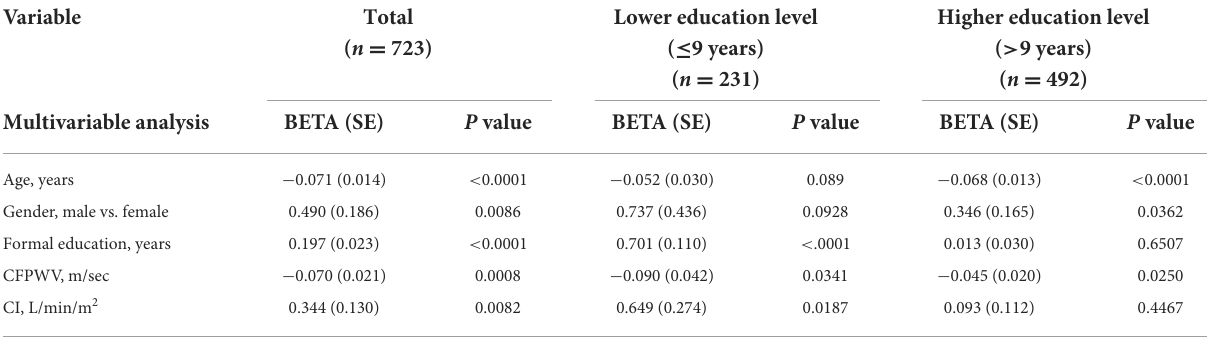
TABLE 2 Association of MMSE with CI and CFPWV, adjusted for age, sex and education whole population and stratified by levels of education.